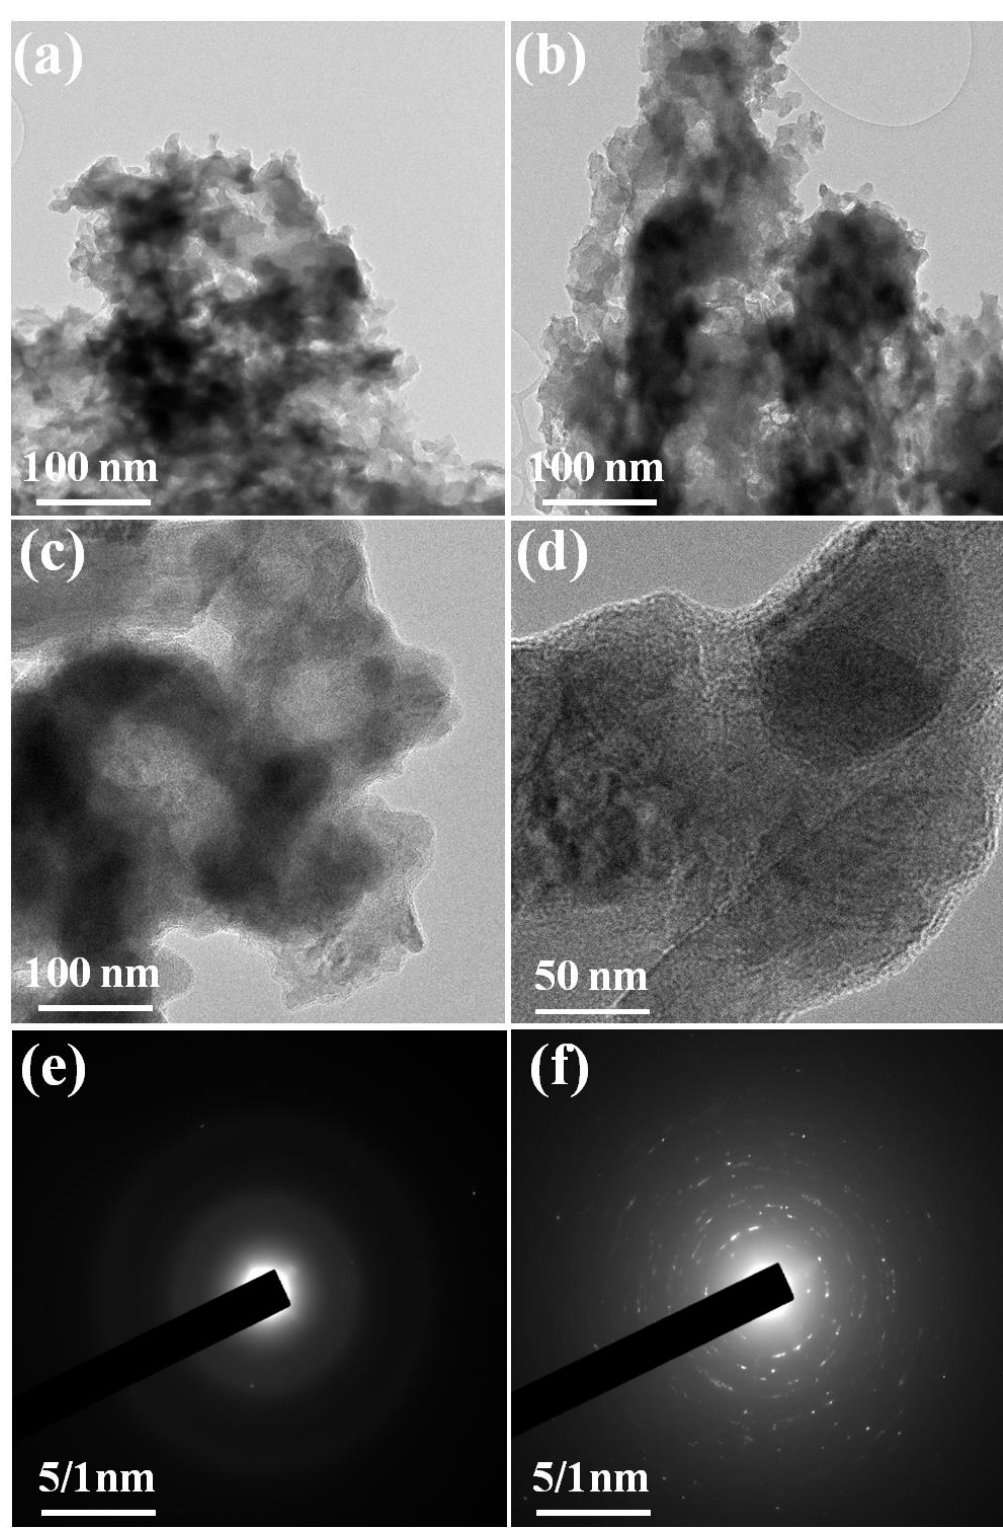
Figure 3. TEM images of the prepared Co(OH) 2 nanoparticles ( a ), Ag-doped@Co(OH) 2 NPs ( b ), and Ag-doped@Co(OH) 2 @polypyrrole NSs ( c , d ); SAED pattern of Ag-doped@Co(OH) 2 NPs